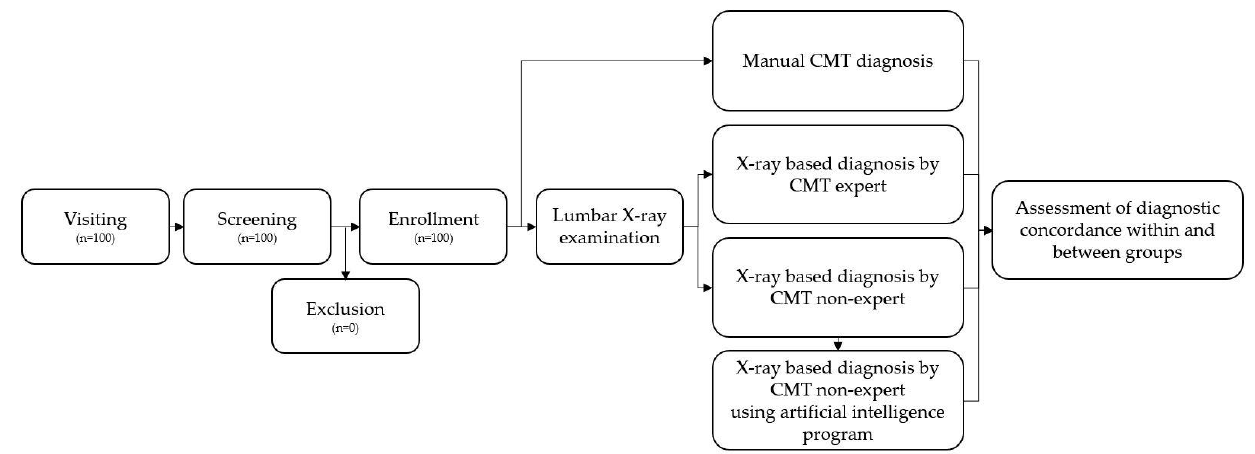
Figure 1. Flow chart of the study. CMT, Chuna manual therapy